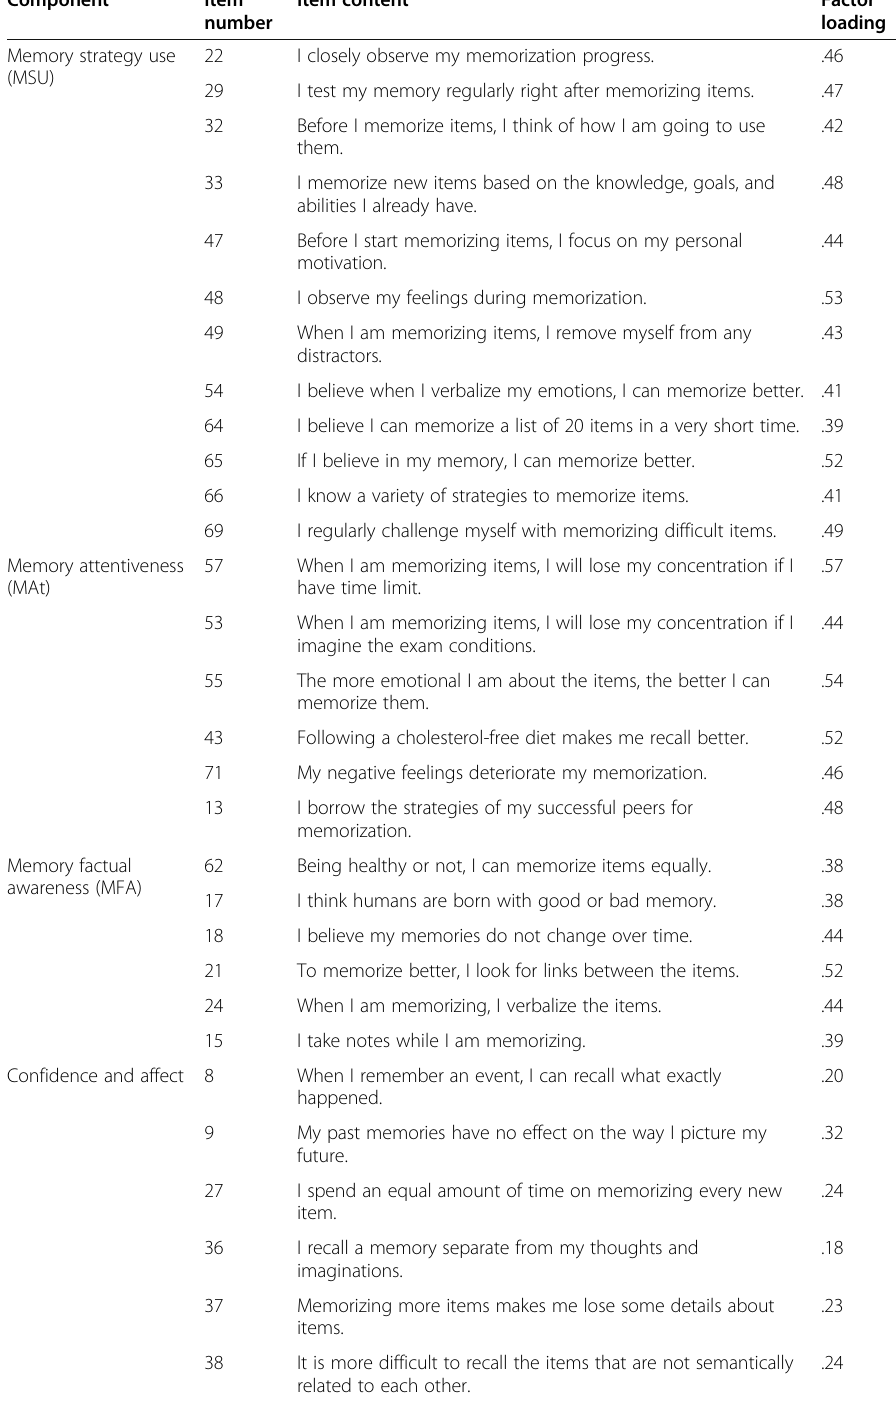
Table 9 Model fit analysis for 30 items in the final MMM questionnaire